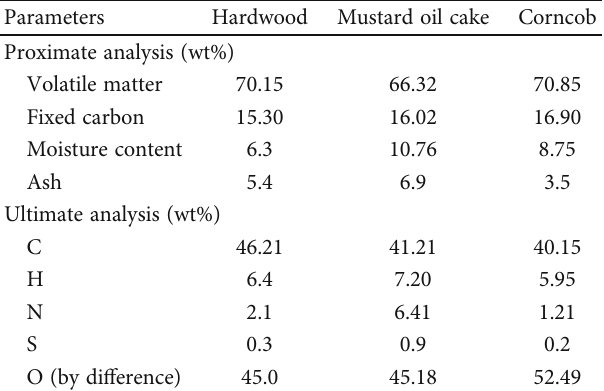
Table 3: Material